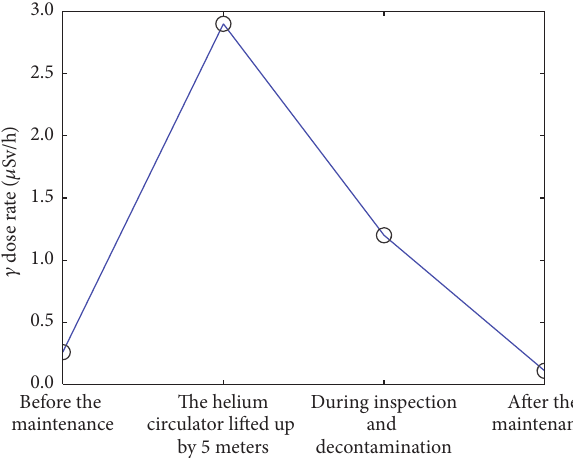
Figure 6: 𝛾 dose rates near the SG flange at different